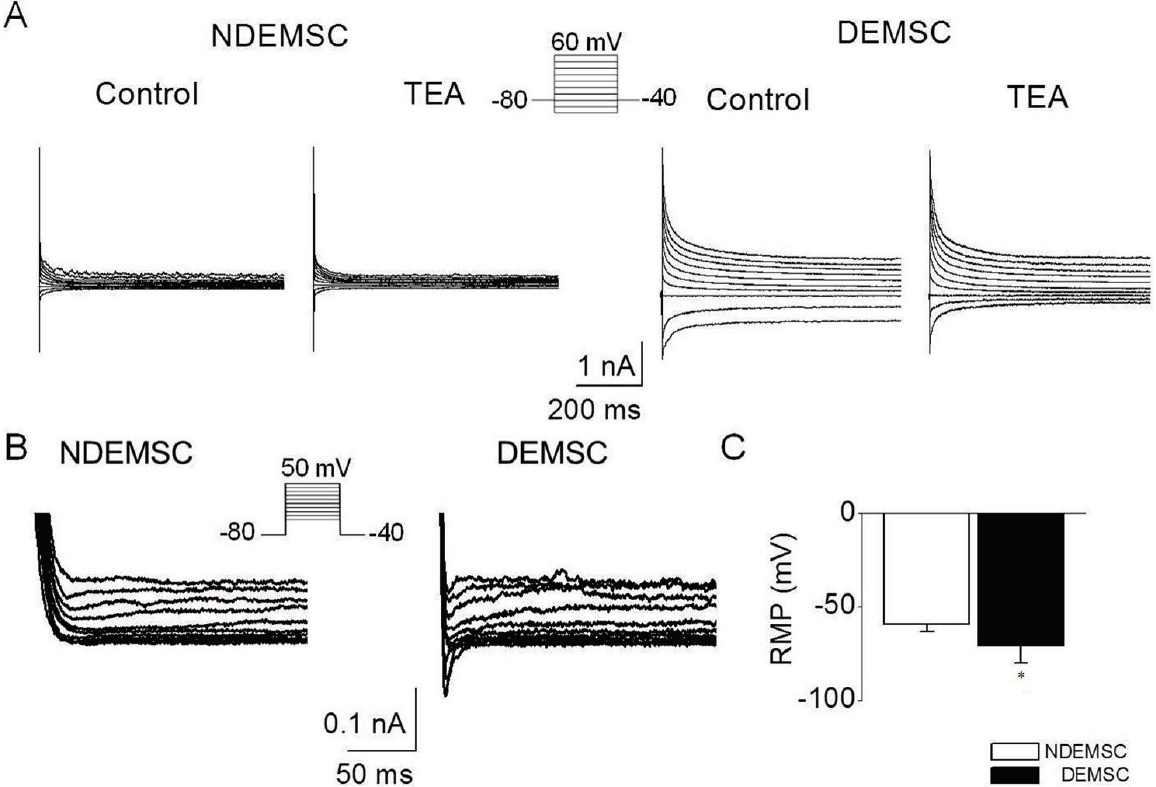
Figure 4. Electrophysiological analysis of porcine EMSCs and neuronal